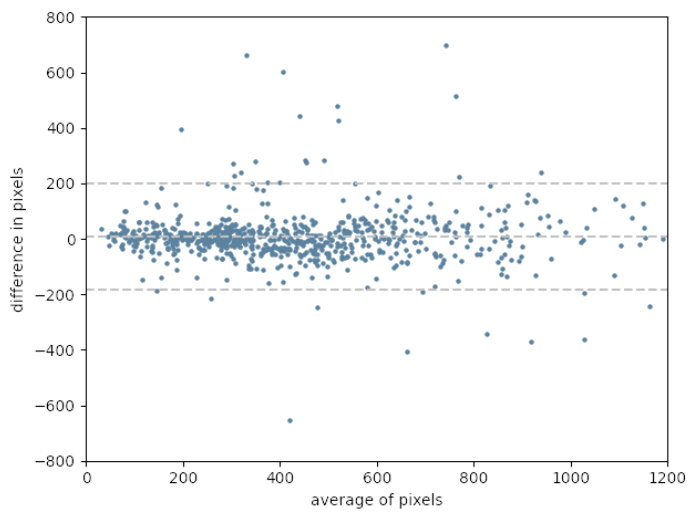
Figure 13. An example of a Bland-Altman plot for EAT volume from